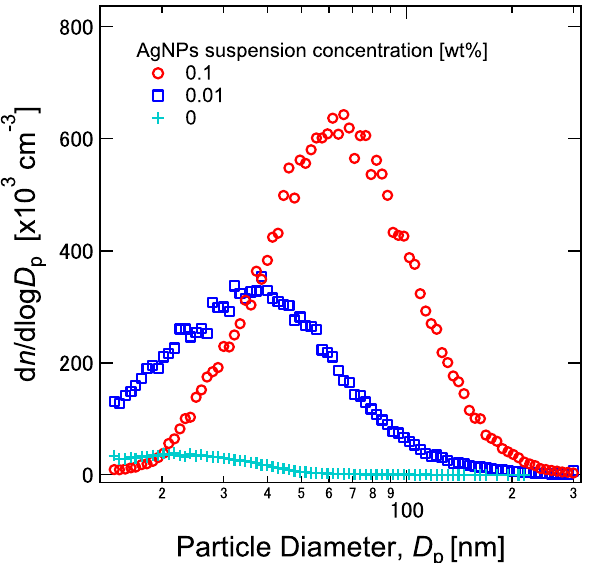
Figure 2. Size distributions of the AgNPs generated from the 0.01-, 0.1-, and 0-wt% sample suspensions. Note that the 0 wt% condition used only ultrapure water for the atomization.